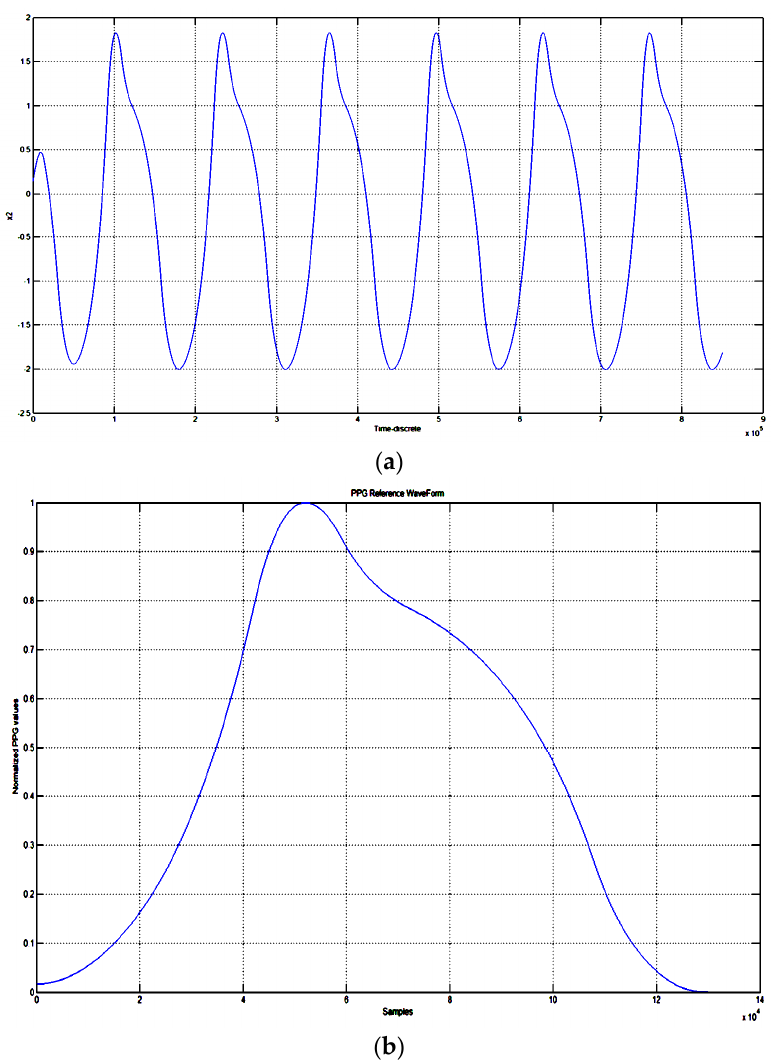
Figure 8. Dynamic evolution of the x 2 variable ( a ). Detail of the normalized [0, 1] single waveform of the x 2 time-evolution ( b ). the x 2 time-evolution ( b